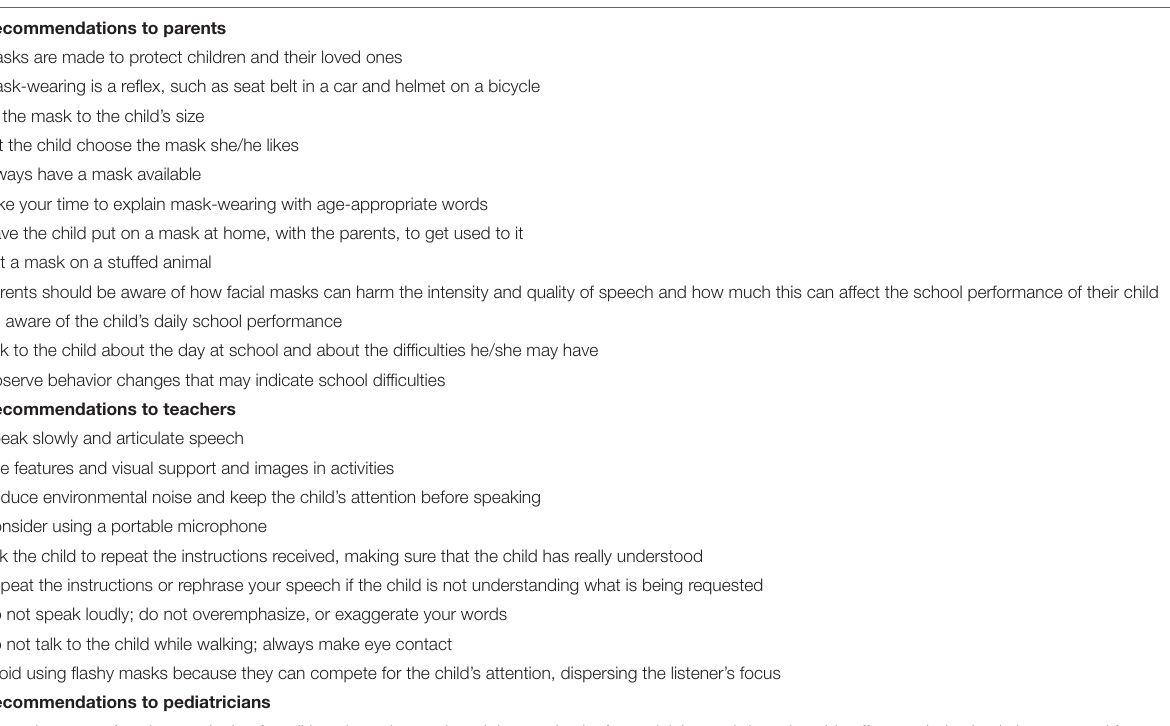
TABLE 1 | Advice for parents/children, teachers and pediatricians to promote and accept wearing a mask [from (34)]. Recommendations to